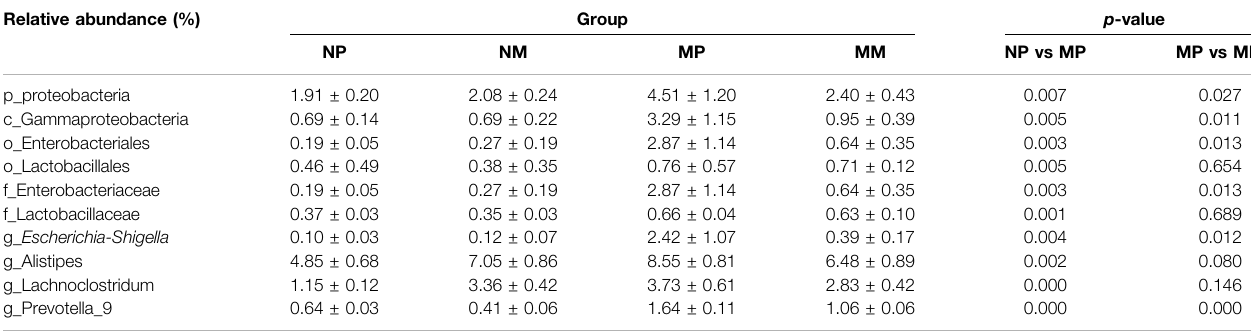
TABLE 1 | Top 10 bacteria at differential levels in the four groups. Relative abundance (%)